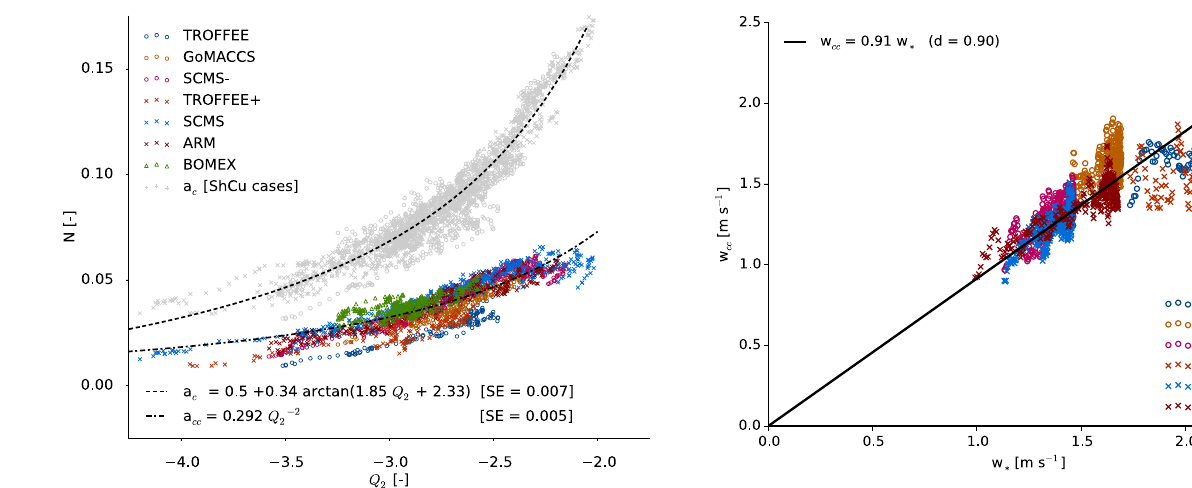
Figure 4. The area fraction of cloud cores ( a cc ) is represented by the coloured symbols, while the a c for all ShCu cases is shown in grey. Both area fractions are shown as a function of the normalized sat- uration deficit at cloud base ( Q 2 ). Crosses denote wind situations, while circles indicate free convection situations. SE represents the residual standard error. The lines represent the best fit parameteri- zations for a c and a cc .